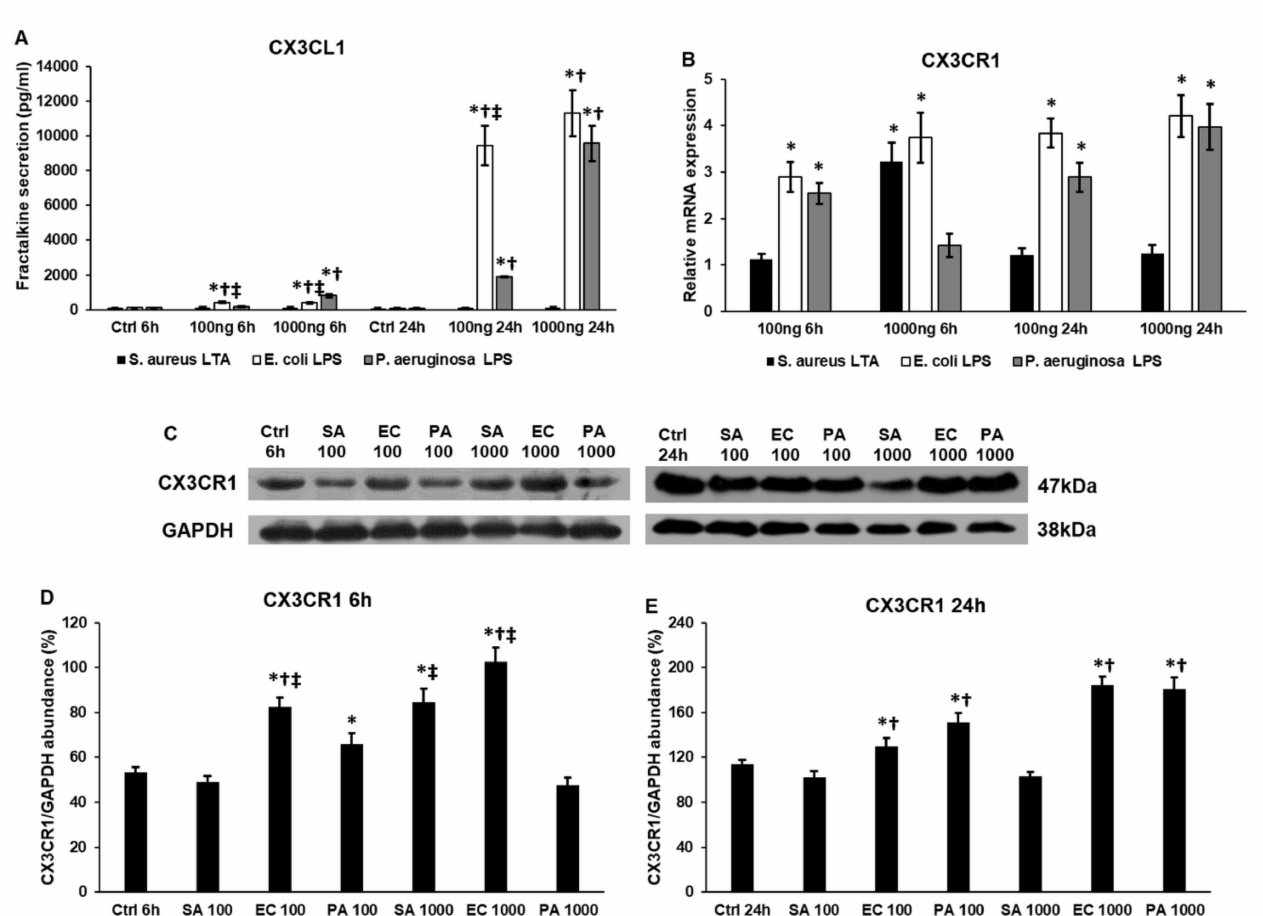
Figure 2. Concentration measurement of fractalkine of lipopolysaccharide (LPS)- and lipoteichoic acid (LTA)-treated THP-1 cells, relative mRNA expression and Western blot analysis of CX3CR1. Secreted fractalkine (FKN) concentrations of the culture media were determined with a human FKN ELISA kit according to the instructions of the manufacturer. Real-time PCR was performed with SYBR Green protocol. β -actin was used as internal control for the normalization. The relative expression of untreated controls was regarded as 1. The mRNA expressions of the treated cells were compared to their appropriate controls (6 h and 24 h). THP-1 cells were collected and pelleted after LPS and LTA treatments. The same amount of protein from each lysate was separated by SDS-PAGE using 12% polyacrylamide gel, and transferred by electroblotting to nitrocellulose membranes. The membranes were probed with anti-CX3CR1 polyclonal rabbit antibodies according to the manufacturer’s protocol. GAPDH was used as loading control. ( A ) Secreted FKN concentration of THP-1 cells treated with S. aureus LTA, E. coli LPS and P. aeruginosa LPS. ( B ) mRNA expression levels of CX3CR1 of THP-1 cells treated with LTA and LPS isolated from different sources. ( C ) Western blot analysis of CX3CR1 protein in LTA- and LPS-treated THP-1 cells. ( D , E ) Optical density analyses of CX3CR1 in THP-1 cells. The columns represent mean values and error bars represent standard deviation (SD) of three independent determinations ( n = 3). ELISA measurements and real-time PCR determinations were carried out in triplicate in each independent experiment. An asterisk * marks p < 0.05 compared to the controls. A cross † indicates p < 0.05 compared to LTA treatment and a double cross ‡ shows p < 0.05 compared to P. aeruginosa LPS treatment. Abbreviations: SA: S. aureus LTA; PA: P. aeruginosa LPS; EC: E. coli